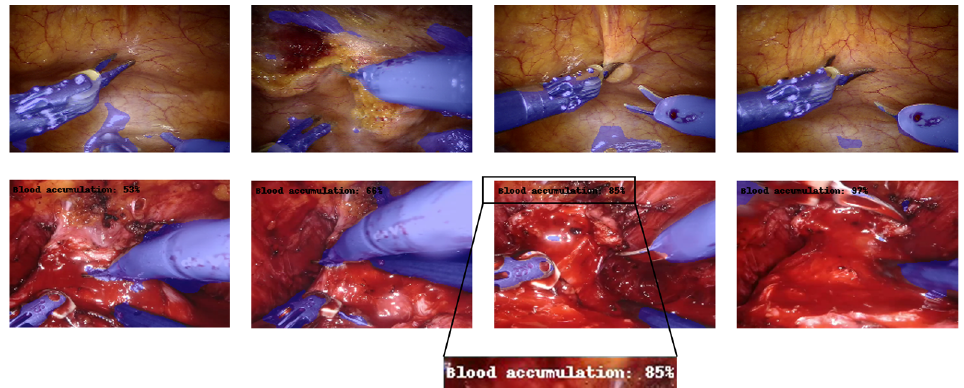
Figure 6. Multi-tasking CNN architecture (example for 160 × 240 input image). Each box represents a multi-channel feature map. Tools detected are blue-colored, while the blood accumulation percentage is indicated in the top-left corner of the image. The first row contains samples for which the percentage of blood accumulation is not displayed because the model predicted a value of less than 50%. The second row, in contrast, displays samples with a blood accumulation percentage greater than 50%.